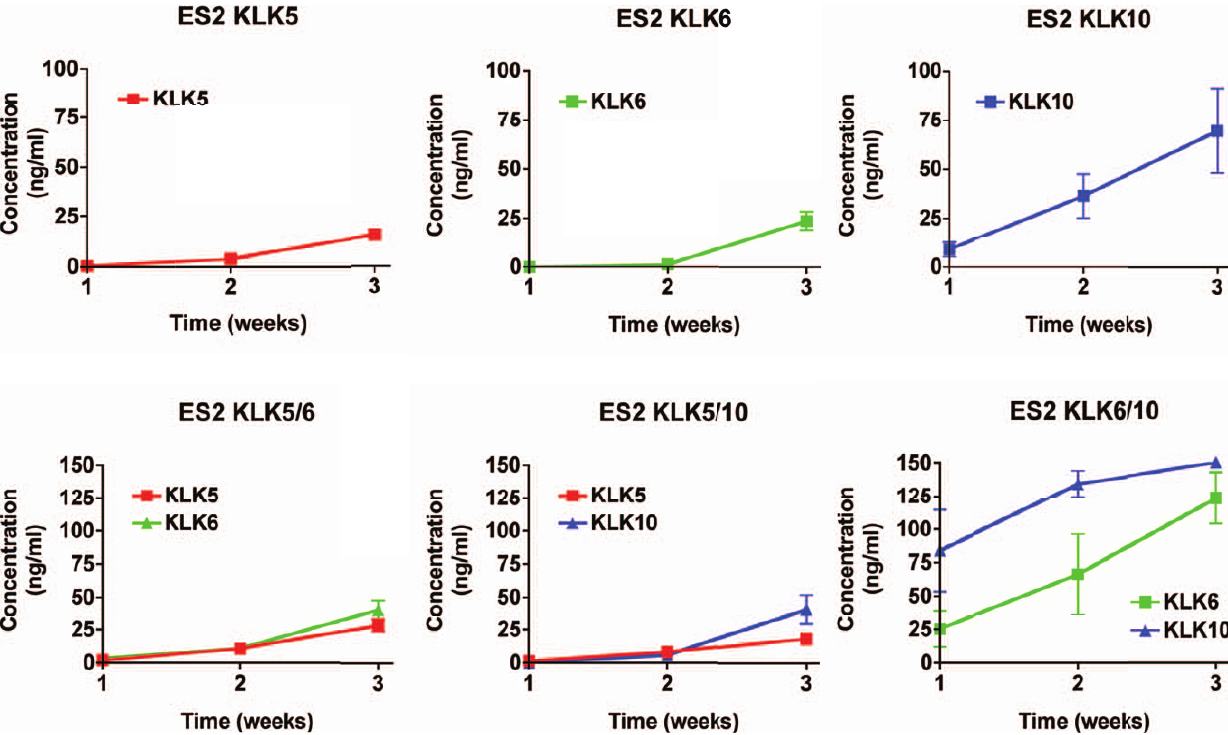
Figure 3. Plasma kallikrein levels reflect the progression of the disease in xenografted mice. Plasma kallikrein levels were recorded weekly by ELISA in the mice xenografted with ES-2 clones overexpressing of KLK5, 6 and 10, alone or in pairs. The last three weekly measurements before endpoint of individual mice were plotted as the mean concentration of the group + / 2 SEM.